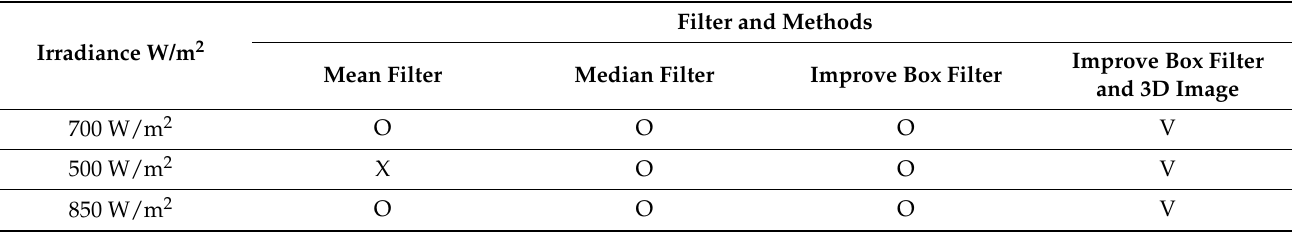
Table 5. Comparison of different irradiance and filtering